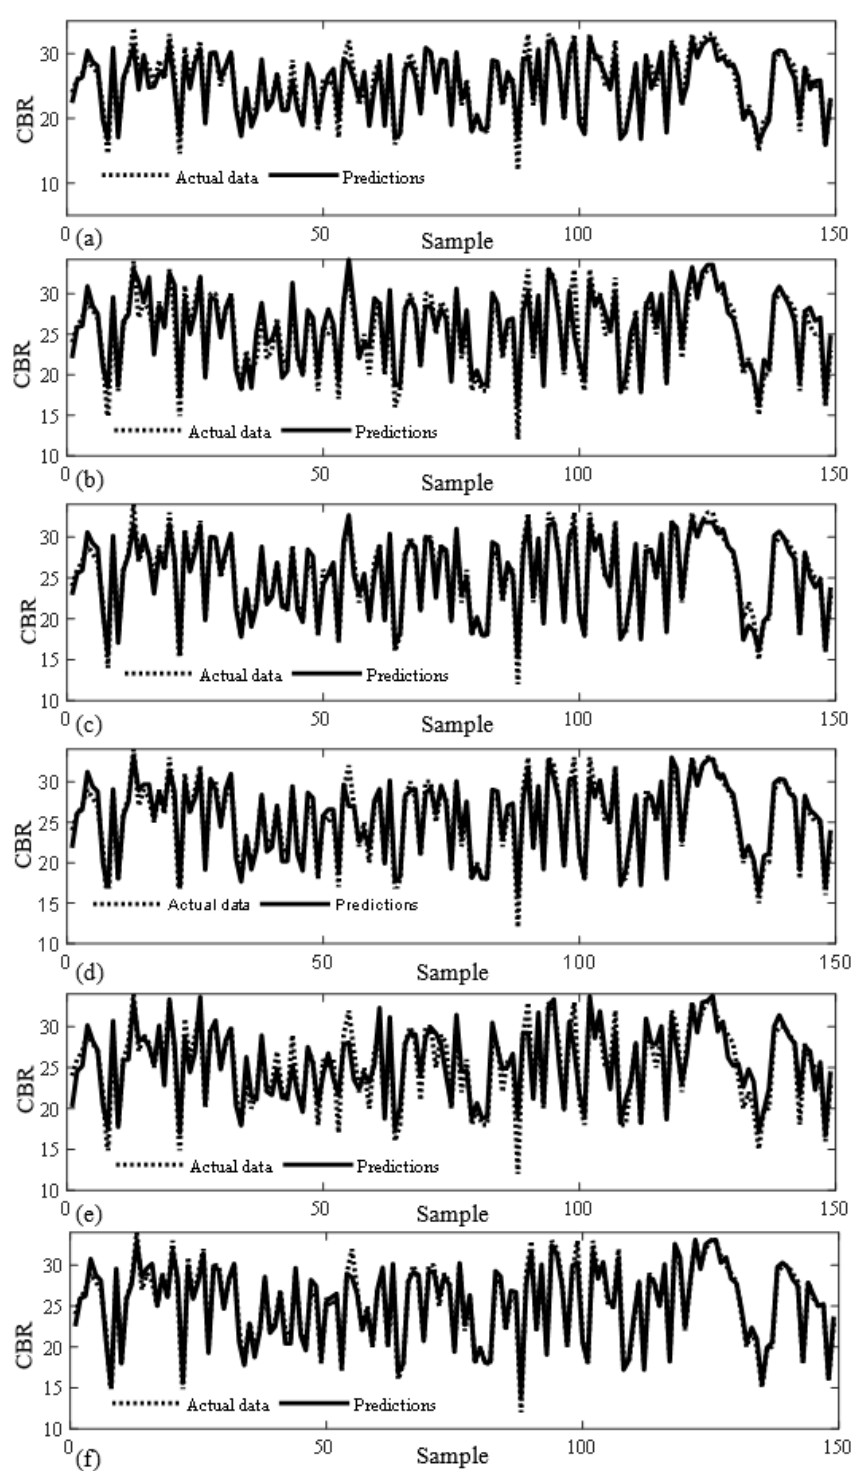
Figure 4. Actual and predicted data of CBR using different activation function; ( a ) ELM with hyperbolic tangent, ( b ) ELM-CSO with hyperbolic tangent, ( c ) ELM with sigmoid, ( d ) ELM-CSO with sigmoid, ( e ) ELM with sinusoidal, ( f ) ELM-CSO with sinusoidal.